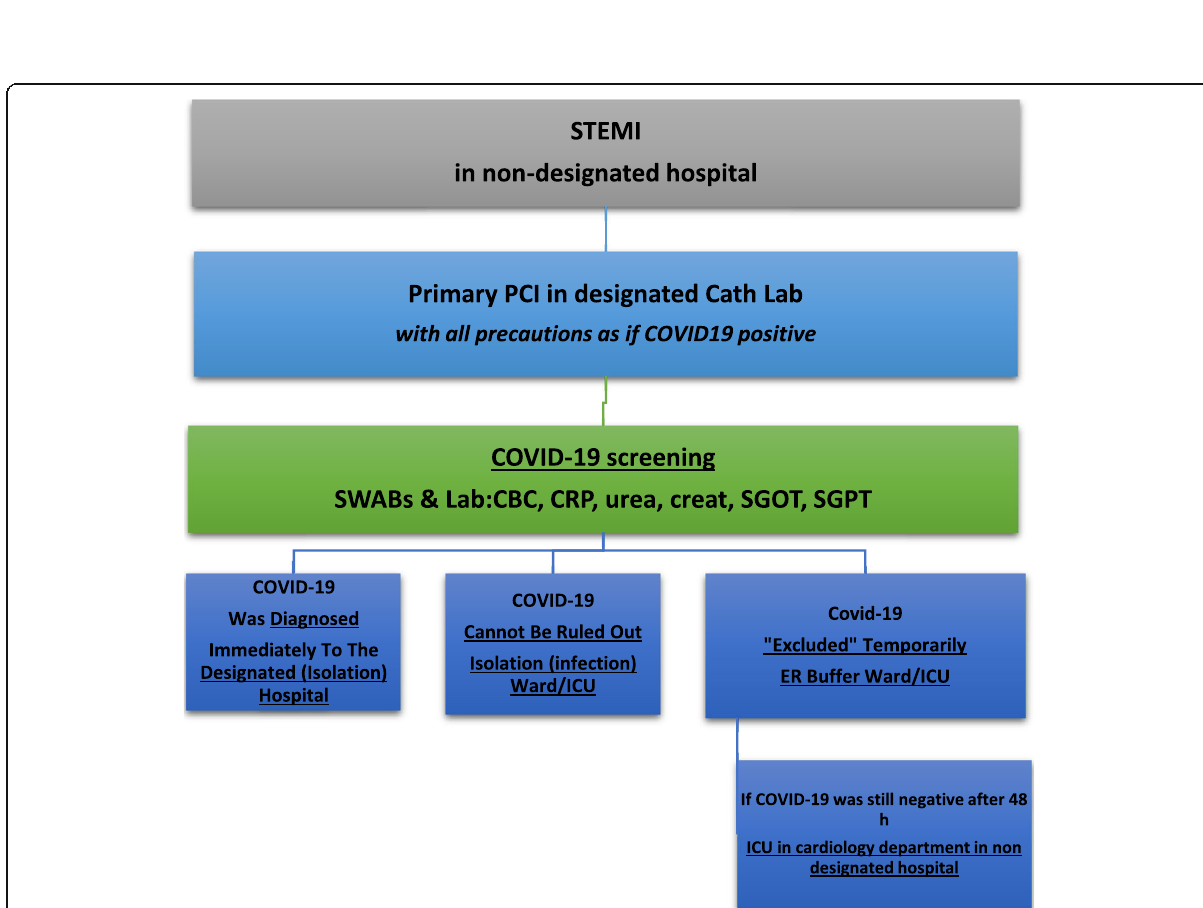
Fig. 4 STEMI management if Primary PCI is the standard